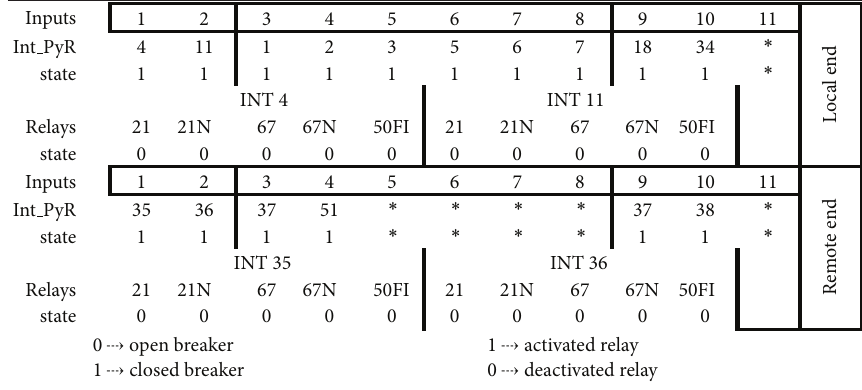
Figure 1: Topology of the interconnection of L. Table 1: Data base for the L neural